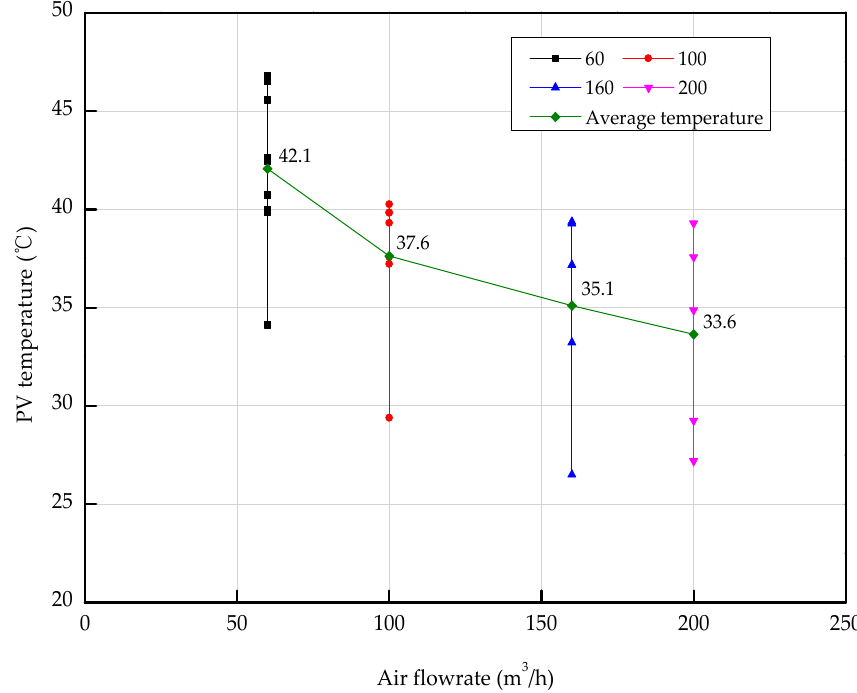
Figure 12. E ff ect of air flow rate on PV Figure 12. Effect of air flow rate on PV temperature.